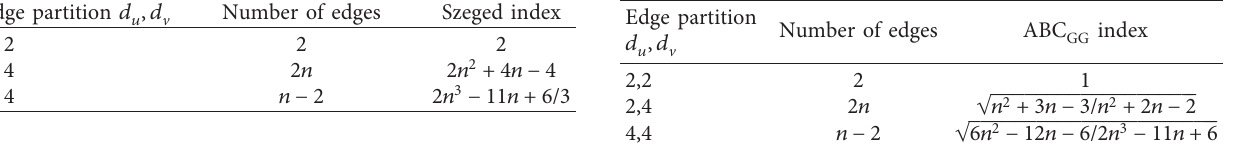
Table 1: Edge partition of oxide network of n order. Edge partition d u , d v Number of edges